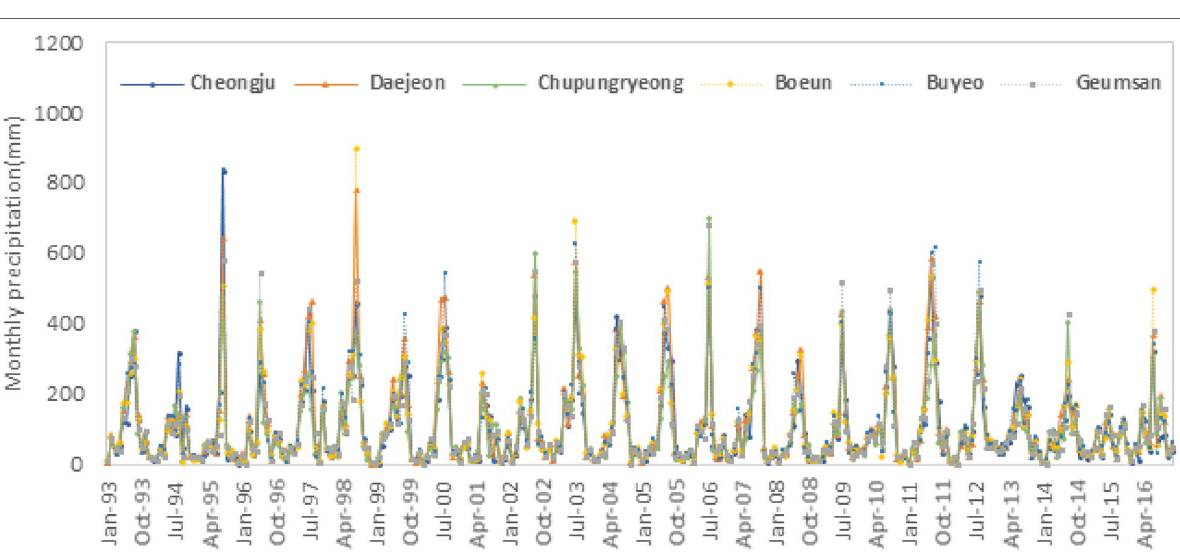
Fig. 3 Monthly precipitation at the six weather stations in Geum river basin (January 1993 to December 2016)